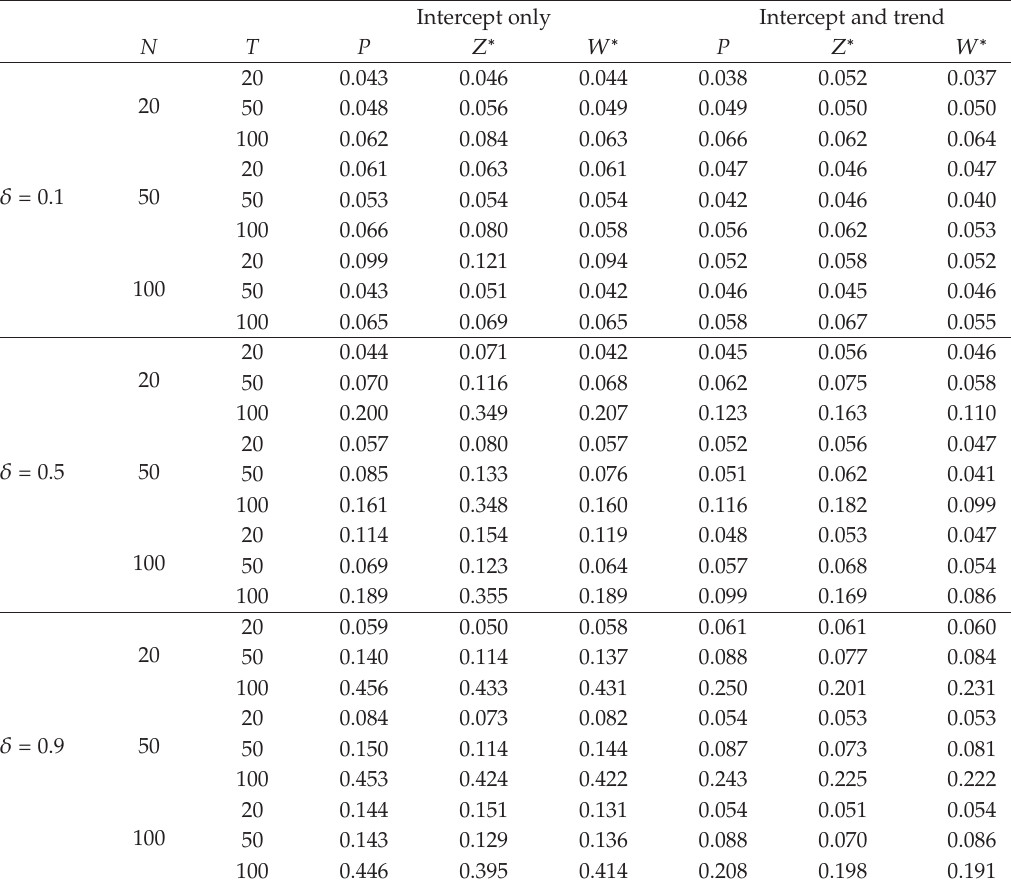
Table 5: Size-adjusted power of panel unit root tests: no serial correlation, cross-section dependence driven by a common